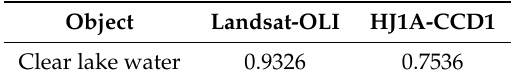
Table 9. The SPSI of natural water.